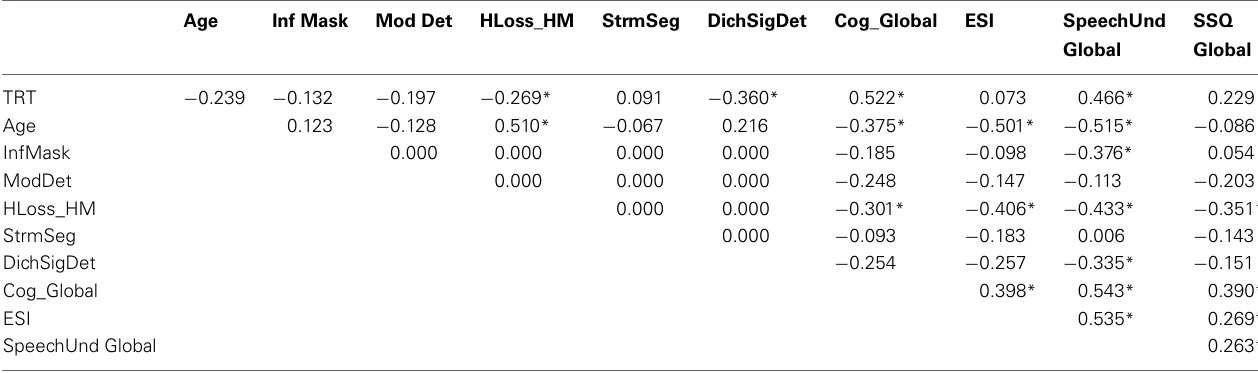
Table 6 | Correlation matrix of selected predictor variables and global speech understanding